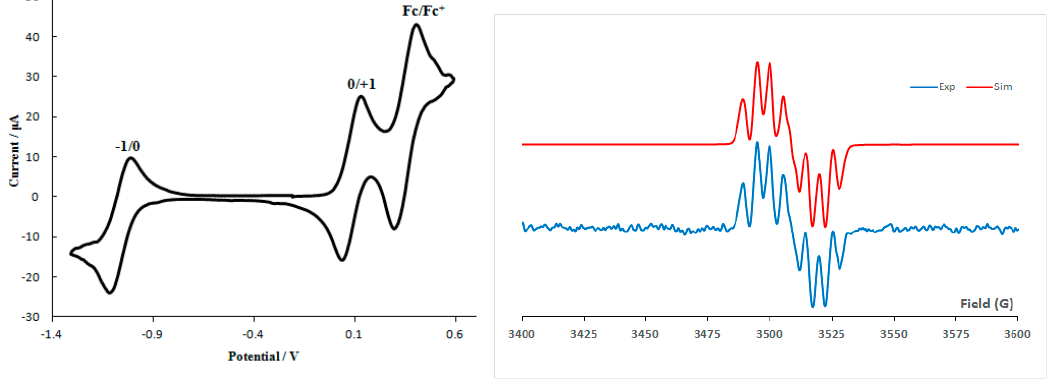
Figure 2. Cyclic voltammetry ( left ) and solution EPR spectrum ( right ) of radical 4 .